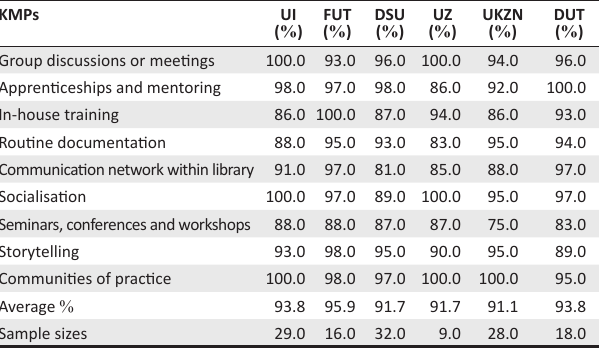
TABLE 1: Forms of knowledge management practices in academic libraries.